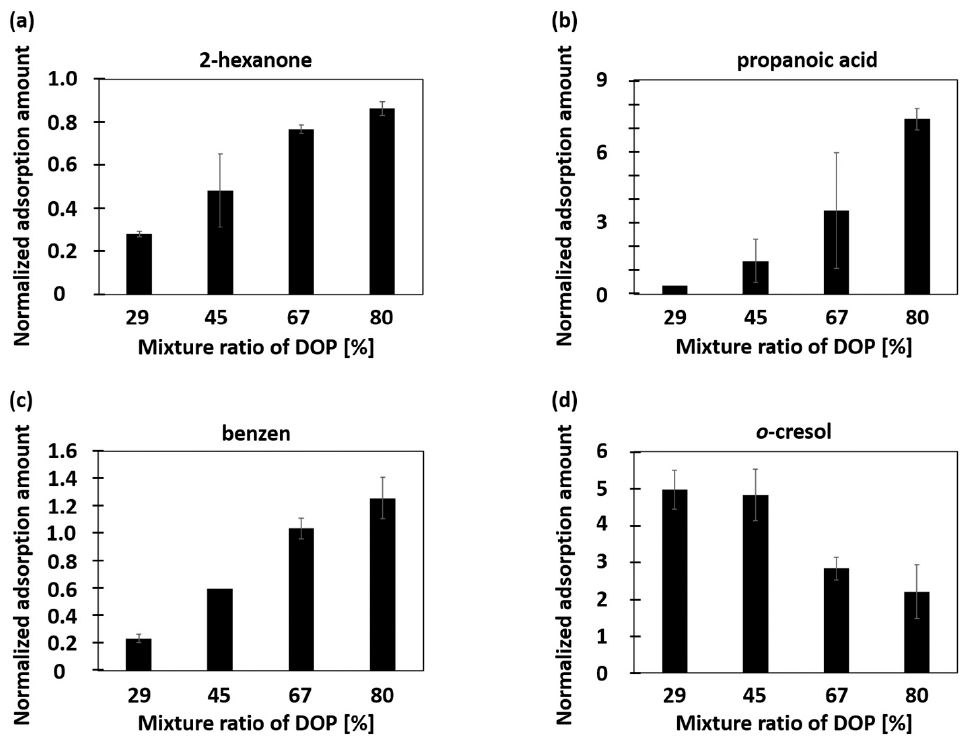
Figure 6. Adsorption properties of polyvinyl chloride–dioctyl phthalate (PVC-DOP) adsorbents as a function of DOP content, relative to those of polydimethylsiloxane (PDMS) adsorbents. Adsorption of ( a ) 2-hexanone; ( b ) propanoic acid; ( c ) benzene; ( d ) o -cresol.